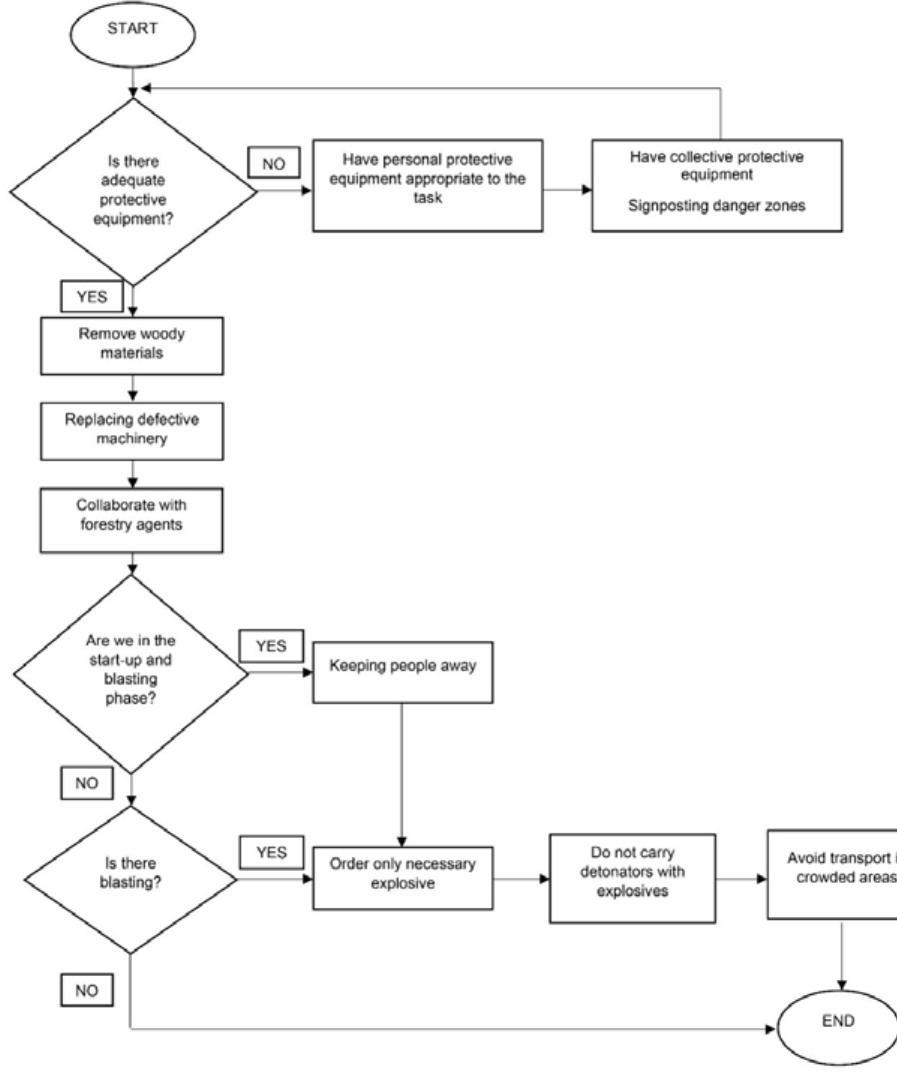
Fig. 8: Flow chart for improving the health and safety of workers in quarrying